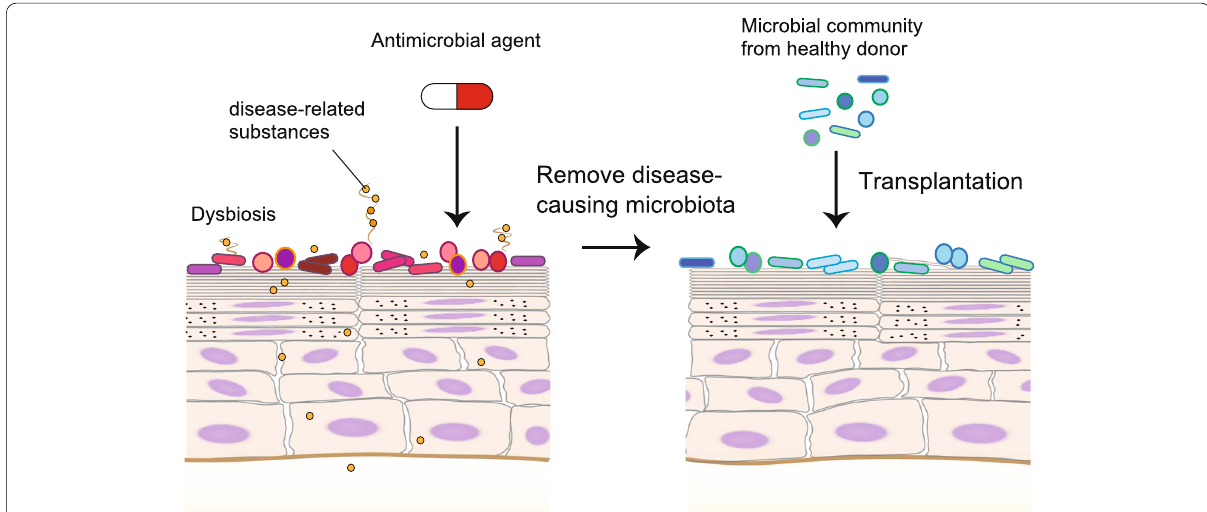
Fig. 2 Transplantation of skin microbial community. One therapeutic strategy using live bacteria for skin diseases is transplantation of the whole skin microbial community from healthy donors to diseased skin associated with dysbiosis, such as patients with malodor. Pre-colonized disease-causing skin microbiota are removed by antibacterial agents such as antibiotics. Subsequently, the microbial community collected from the skin of non-odorous donors is transplanted to the patient’s skin to occupy space and provide nutrition, preventing other bacteria from colonizing the skin niche and producing disease-causing